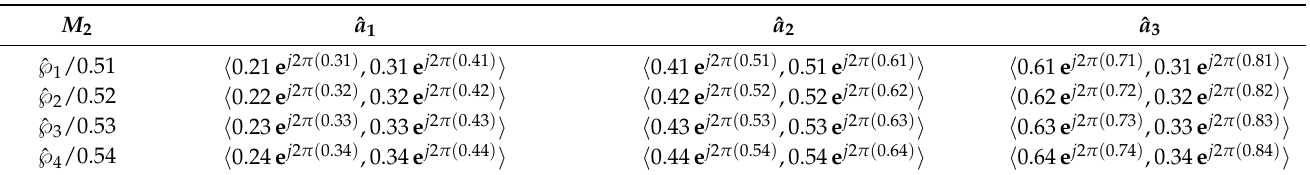
constructed with Dm 2 . Dm 2